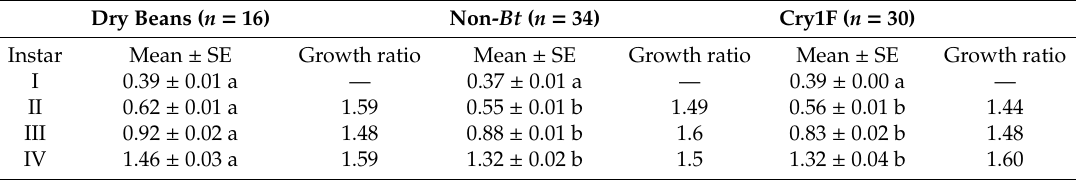
Figure 4. Mean duration (days ± SE) of S. albicosta active feeding larvae, during each instar, from larvae reared on dry beans, non- Bt maize, and Cry1F maize, under controlled conditions. Different letters indicate significant differences between diets within an instar ( p < 0.05). Comparison of means based on Tukey’s test. Table 2. Width (mm) of head capsules of S. albicosta at each instar and respective growth ratios from larvae reared on dry beans, non- Bt maize, and Cry1F maize under controlled conditions. Sample sizes indicated by n represent those larvae that survived to pupation and whose head capsules were recovered at every instar.